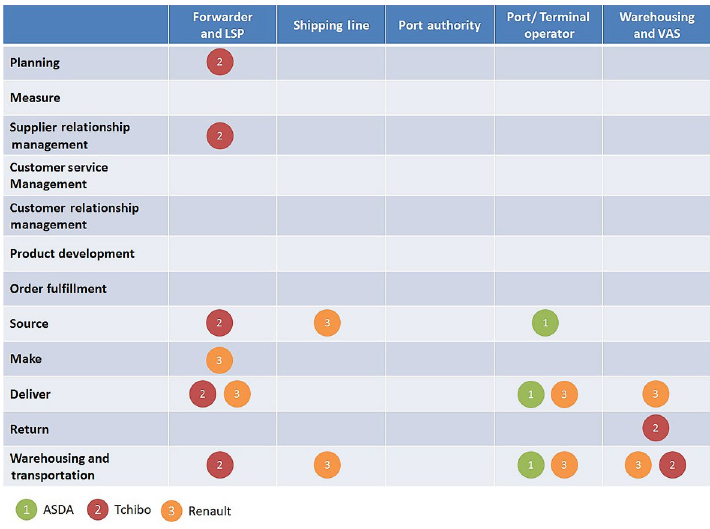
Fig. 2. Port actor-SCM subsystems matrix (compiled by the